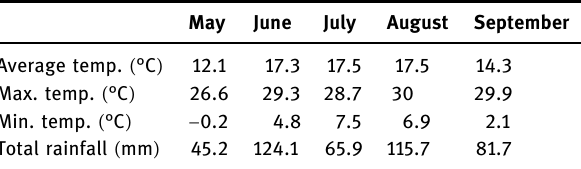
Table 1: Weather data during the time samples were taken. Averages were typical for that of a Central Ontario